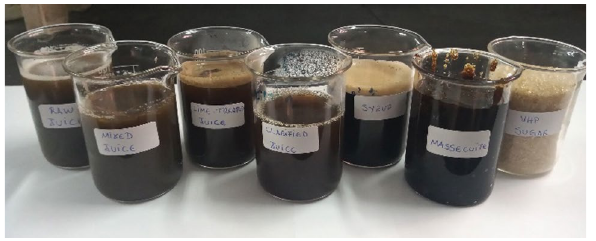
Figure 1. Major products obtained from the VHP sugar manufacturing process: raw juice, mixed juice, lime- treated juice, clarified juice, syrup, massecuite, and VHP